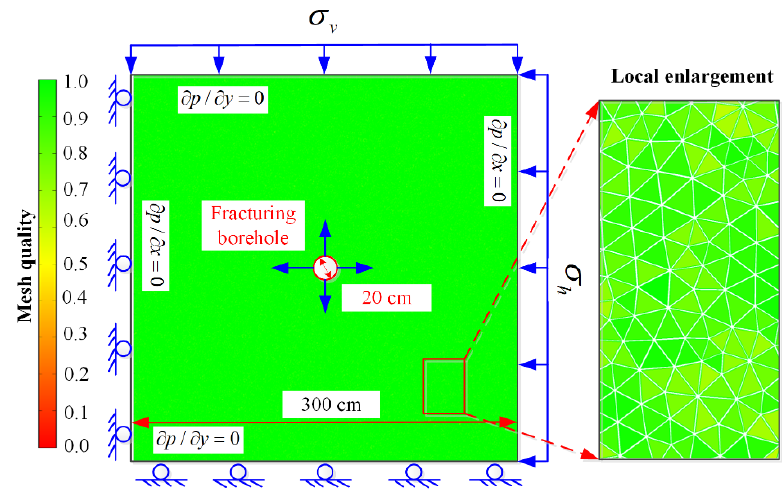
Figure 5. Numerical calculation model of hydraulic fracturing and boundary conditions.